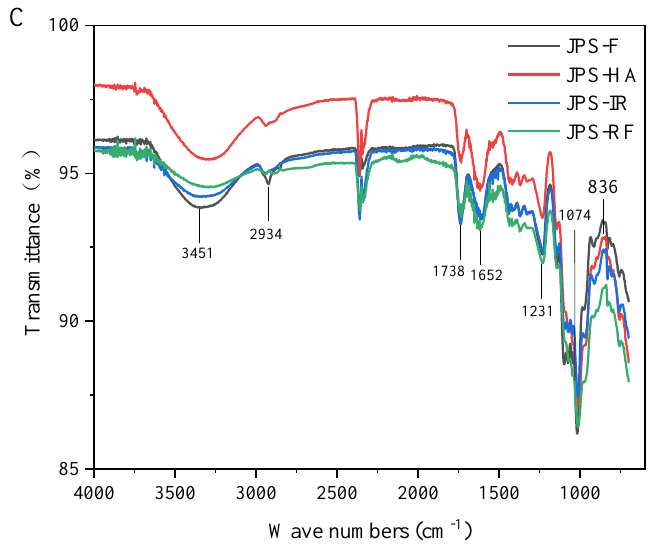
Figure 2. Thermogravimetric analysis ( A ), apparent viscosity ( B ), and FT-IR spectra ( C ) of JPSs dried under different methods.